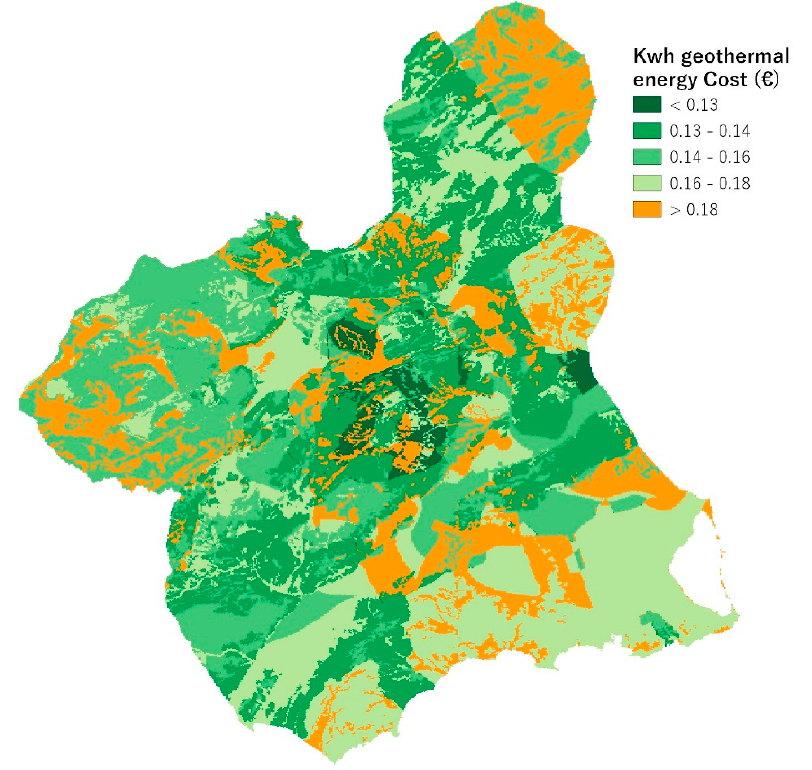
Figure 12. Map of the production cost of geothermal energy (€/kWh).